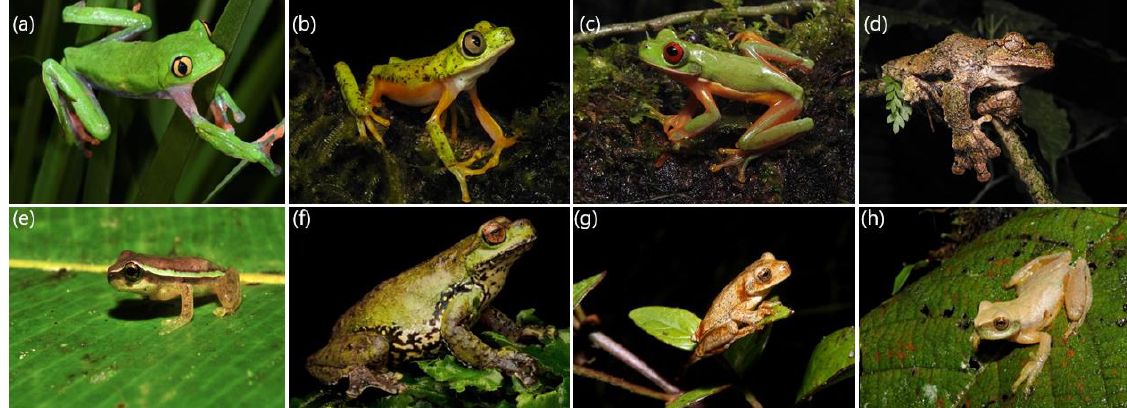
Figure 2. Study species: ( a ) blue-sided treefrog, Agalychnis annae (picture, Alex Shepack ); ( b ) lemur leaf frog, Agalychnis lemur (picture, Stanley Salazar); ( c ) Costa Rica brook frog, Duellmanohyla uranochroa (picture, Stanley Salazar); ( d ) Shaman fringe-limbed treefrog, Ecnomiohyla sukia (picture, Stanley Salazar); ( e ) narrow-lined treefrog, Isthmohyla angustilineata (picture, Fabio Hidalgo); ( f ) Pico Blanco treefrog, Isthmohyla pictipes (picture, Andrey Solís); ( g ) Gunther’s Costa Rican treefrog, Isthmohyla pseudopuma (picture, Víctor Acosta-Chaves); ( h ) American cinchona plantation treefrog, Isthmohyla rivularis (picture, Víctor Acosta-Chaves). Reproduced with permission from Fabio Hidalgo and Andrey Solís.